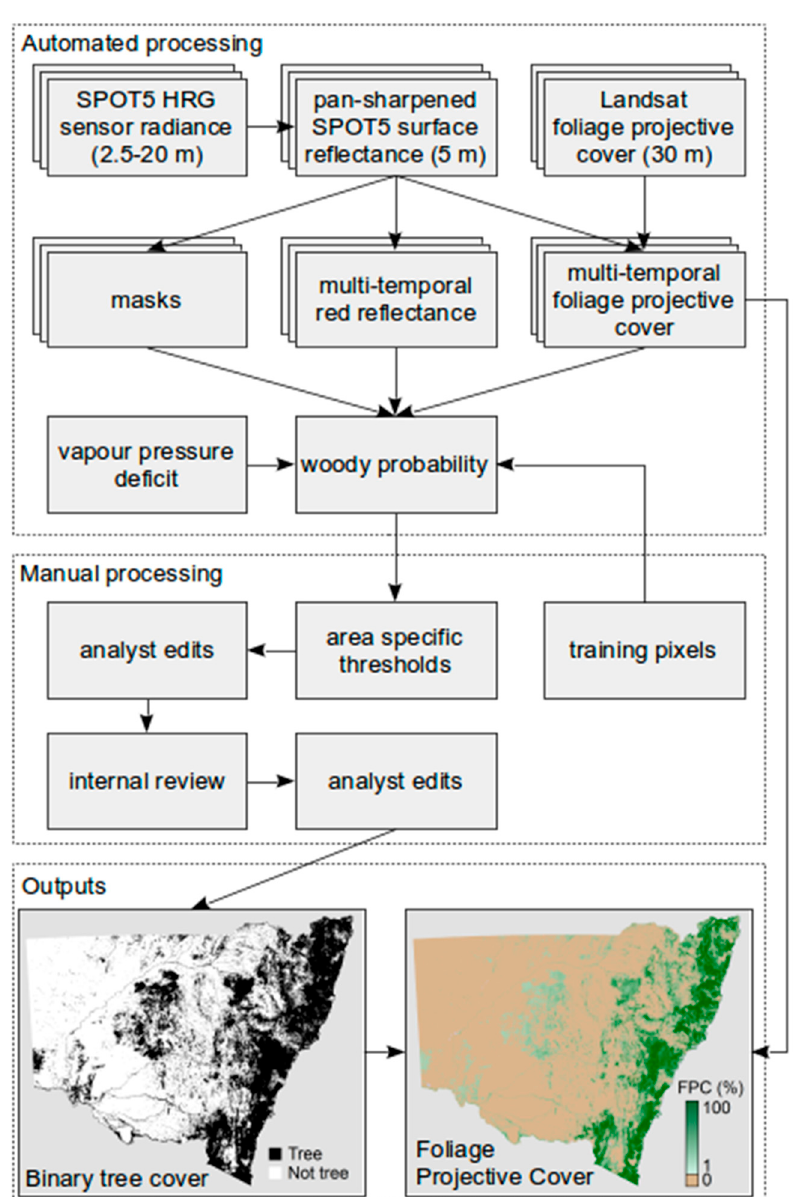
Figure 2. The method combined automated and manual processing to output the 5 m binary tree cover map and foliage projective cover (FPC) map of New South Wales, Australia. Manual processing steps were assisted by high resolution imagery (0.5–2.5